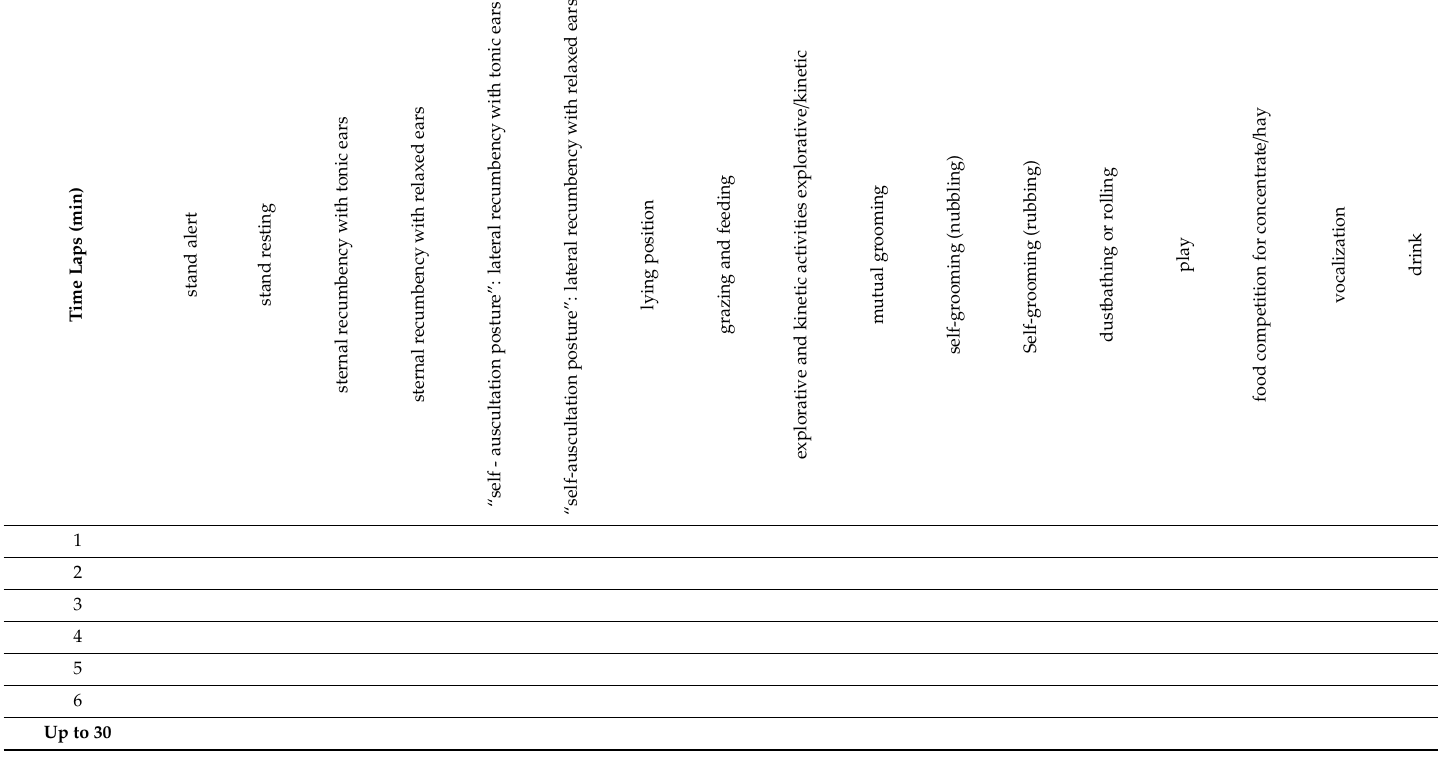
Table 2. Checklist used to quantify behavioral states or behavioral events of Equus asinus